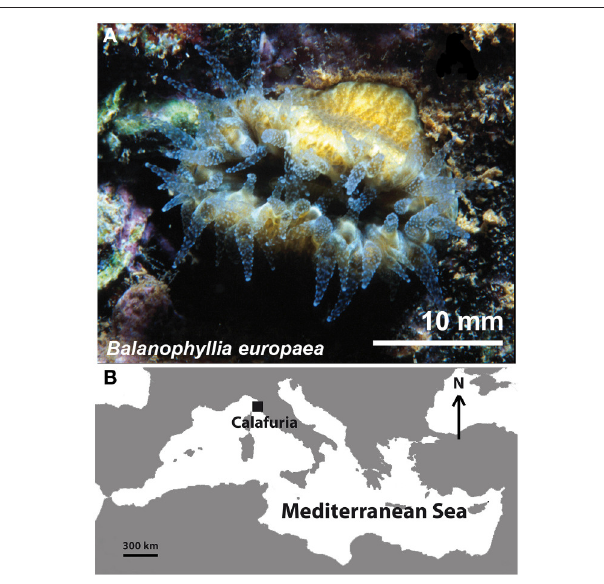
FIGURE 1 | Balanophyllia europaea . Living specimen (A) and map (B) of the Mediterranean Sea indicating the Calafuria site where corals were collected (43 ◦ 27 ′ N, 10 ◦ 21 ′ E).